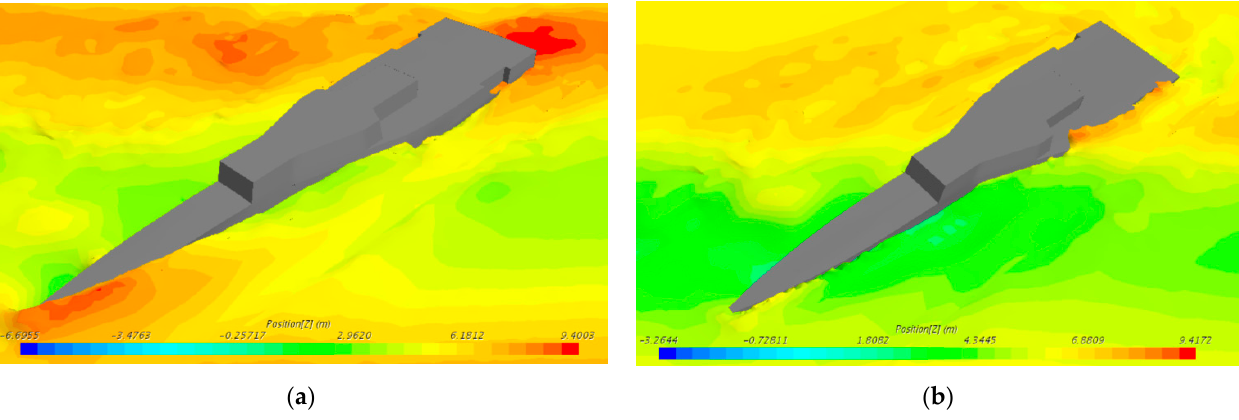
Figure 19. Phenomena of green water corresponding to θ = 45°. ( a ) Green water on foredeck; ( b ) Green water on afterdeck.